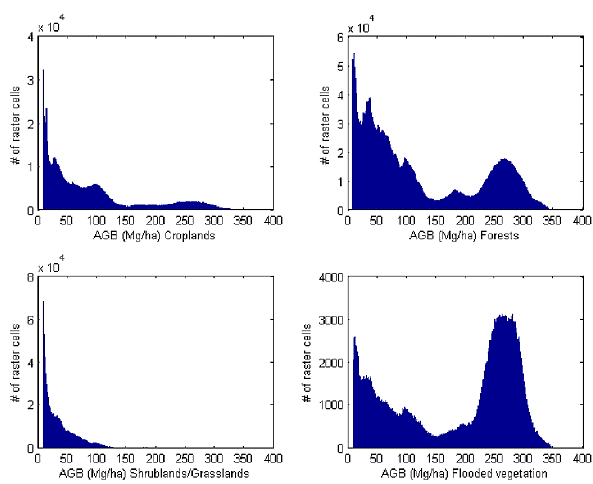
Fig. 1. Histograms of biomass for different land cover aggregated classes (see Table